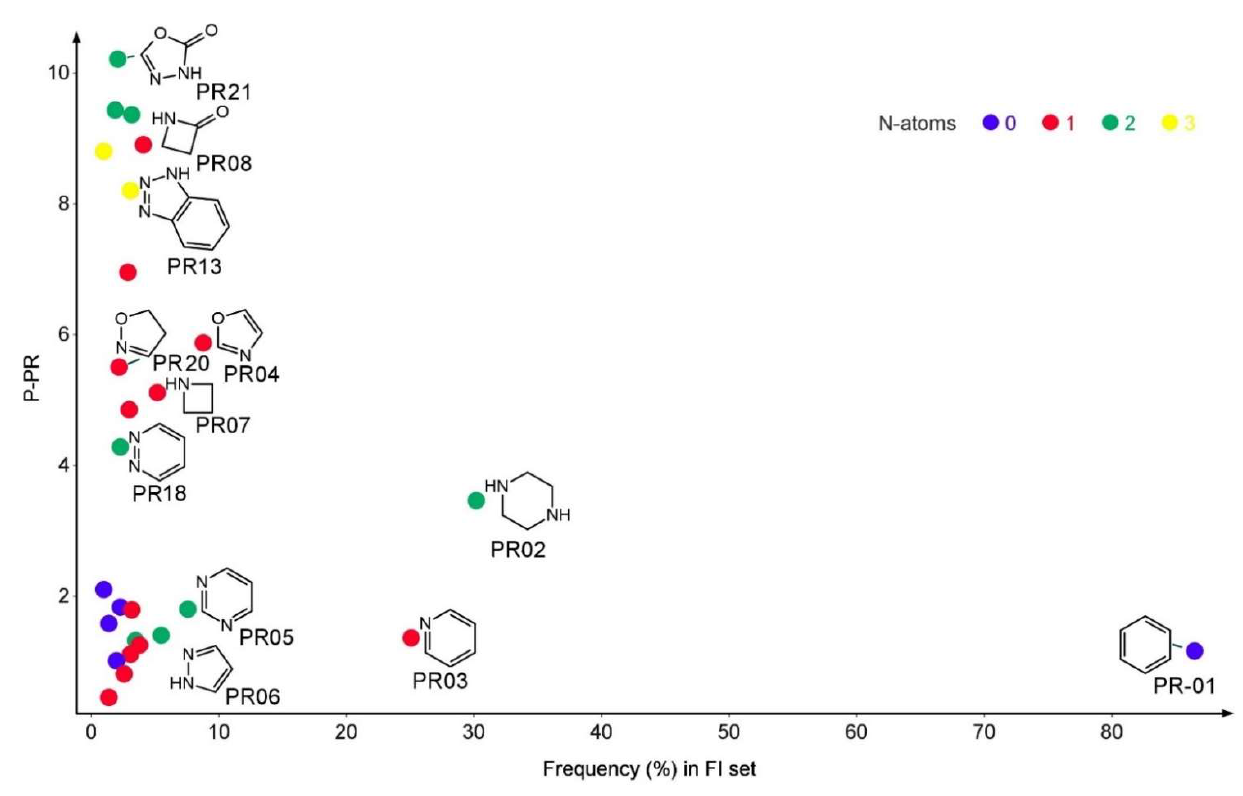
Figure 2. The plain rings (PR) performance score in relation to the frequency of distribution in the FI set and the number of nitrogen atoms. The plots represent only the PR structures with a prevalence of over 1%.